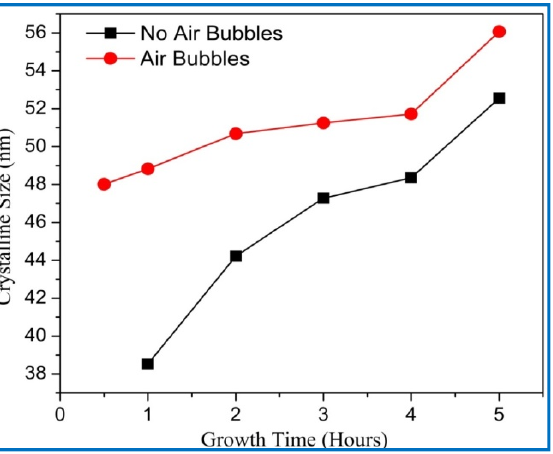
Figure 10. Variation of crystalline size of ZnO nanorods of diffraction peak (002) with growth time for both cases: air bubbles not involved and air bubbles involved.